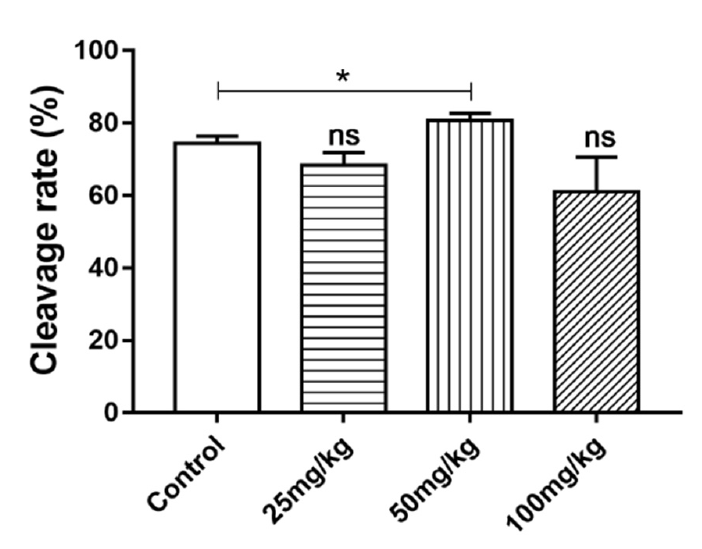
Figure 5. Effects of different concentrations of DSF on cleavage rate of mice oocytes in Vitro. * p < 0.05, ns p > 0.05. Each group tested more than 100 MII oocytes.